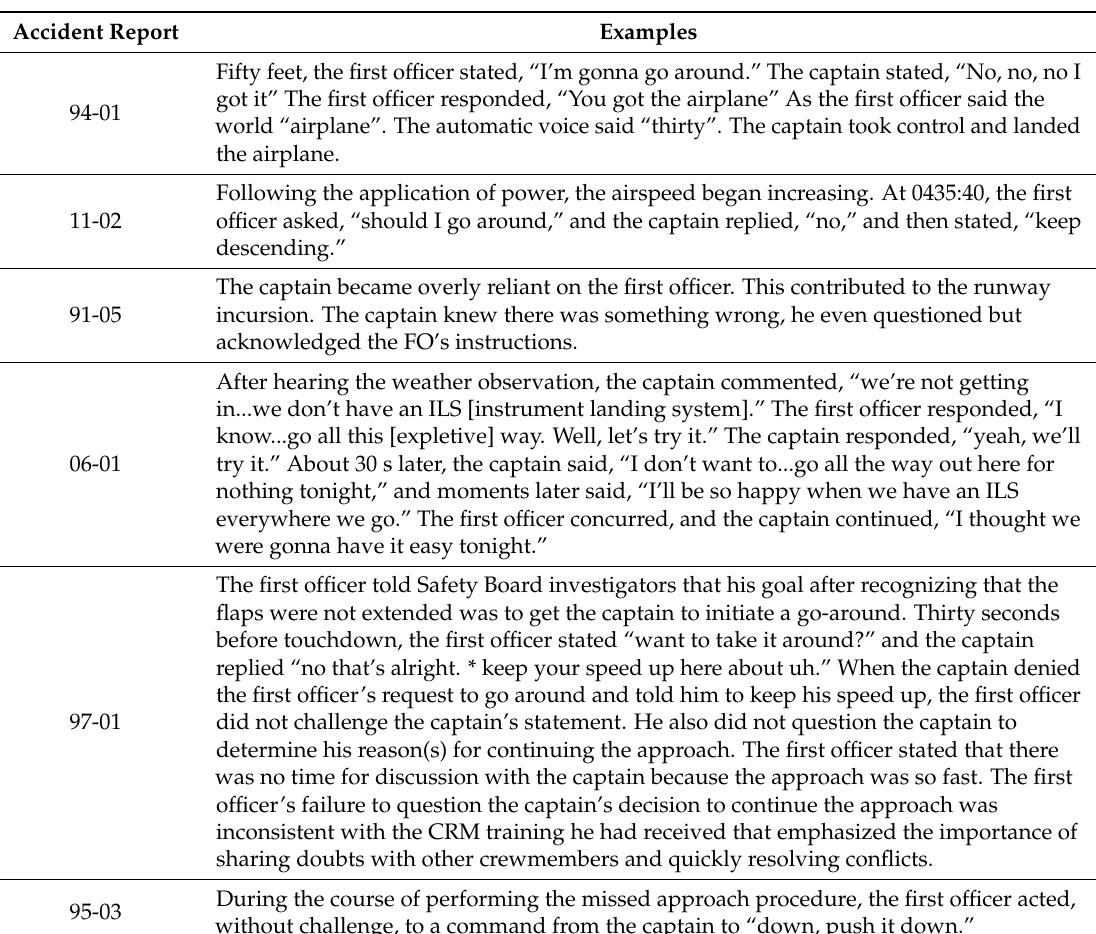
Table 5. Examples of Peer Pressure.